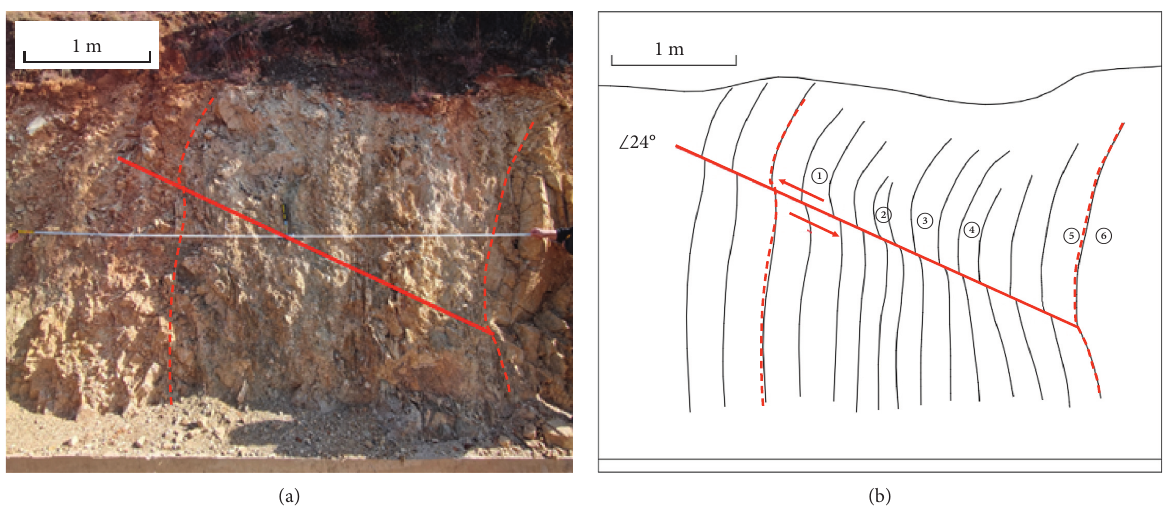
Figure 4: Outcrop of secondary weak structure A. (a). A photo of outcrop (b). A sketch of the